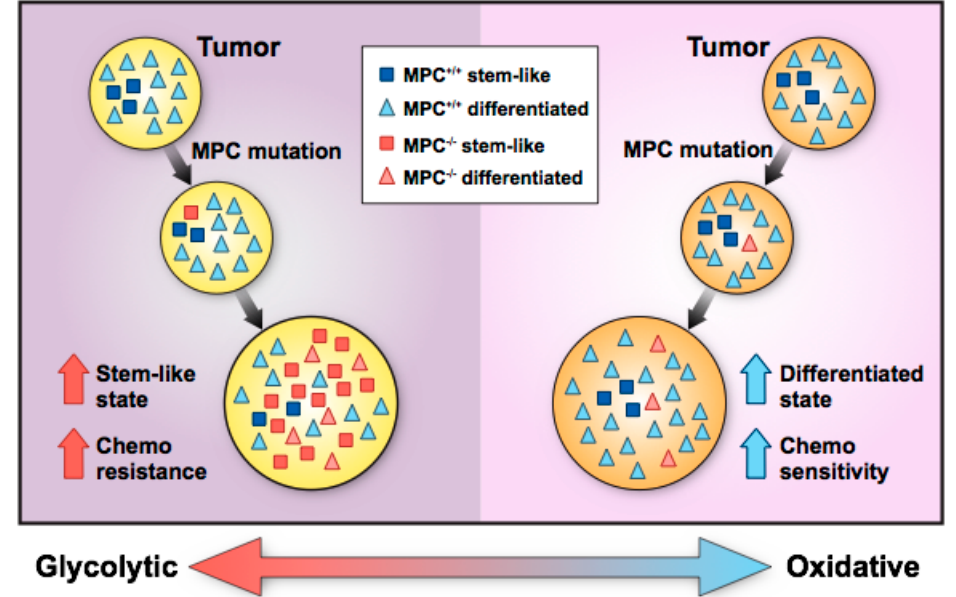
Figure 1. Hypothetical paradigm for the development of mitochondrial pyruvate carrier (MPC)-positive and -negative cancers. Left panel: Lack of MPC expression in stem-like cancer cells increases glycolysis and promotes proliferation, which contributes to tumor initiation and progression. Increased proliferation of MPC-deficient cells leads to a tumor enriched in glycolytic, stem-like cells that convey chemoresistance and invasiveness. Right panel: Sporadic loss of MPC expression in more di ff erentiated, oxidative tumor cells promotes glycolysis but does not accelerate, or even impairs, cell proliferation. The tumor remains mostly oxidative with retained MPC expression, decreased invasiveness, and